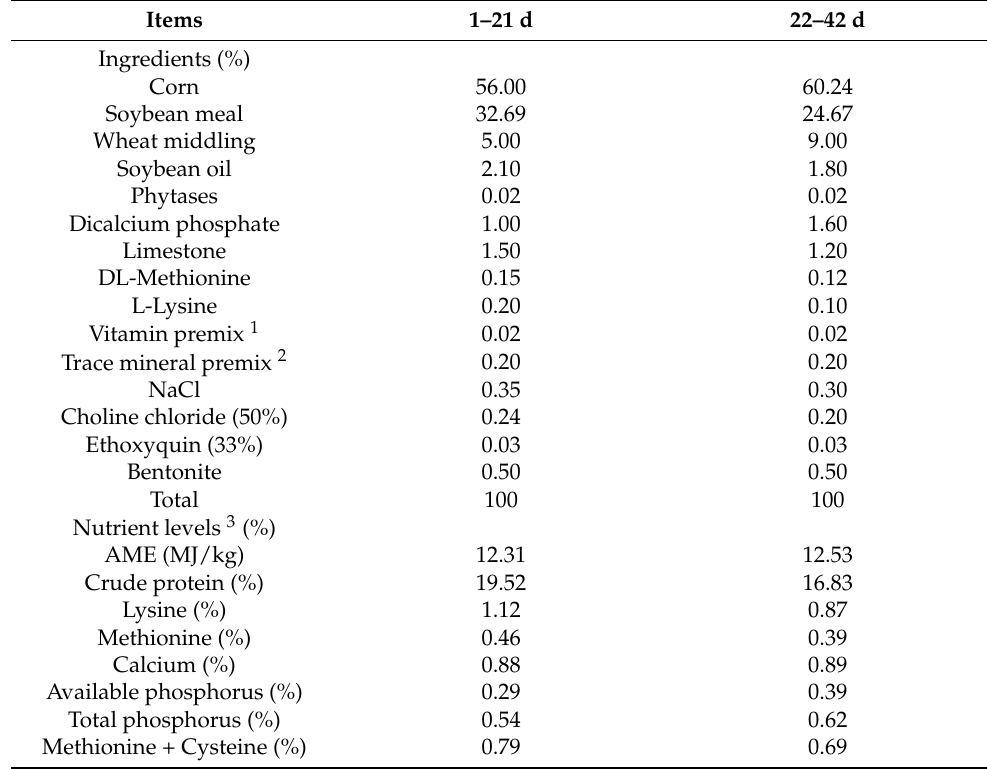
Table 1. Composition and nutrient levels of the basal diets (air-dry